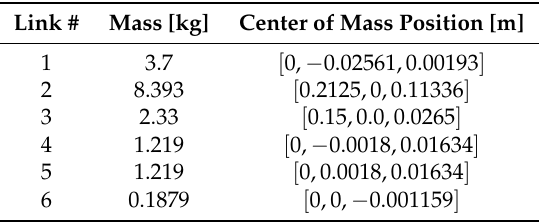
Table 2. Mass properties of the UR5 robot.